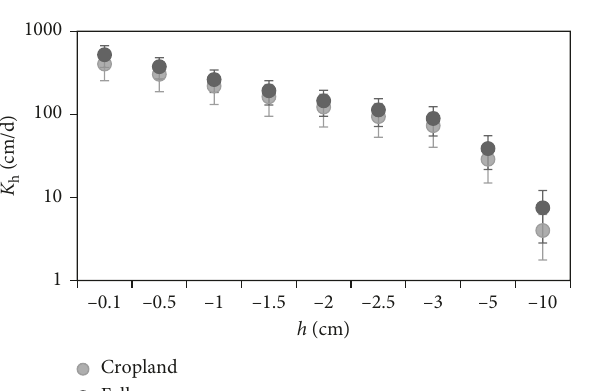
Figure 5: Mean and 95% confidence interval of unsaturated hydraulic conductivity ( K h ) estimated from field measurement with increasing water tension under cropland and Table 4: Soil texture, coarse particles, and bulk density under cropland and fallow at the investigated plots. Cropland Fallow Cropland vs Fallow t -test p Variable